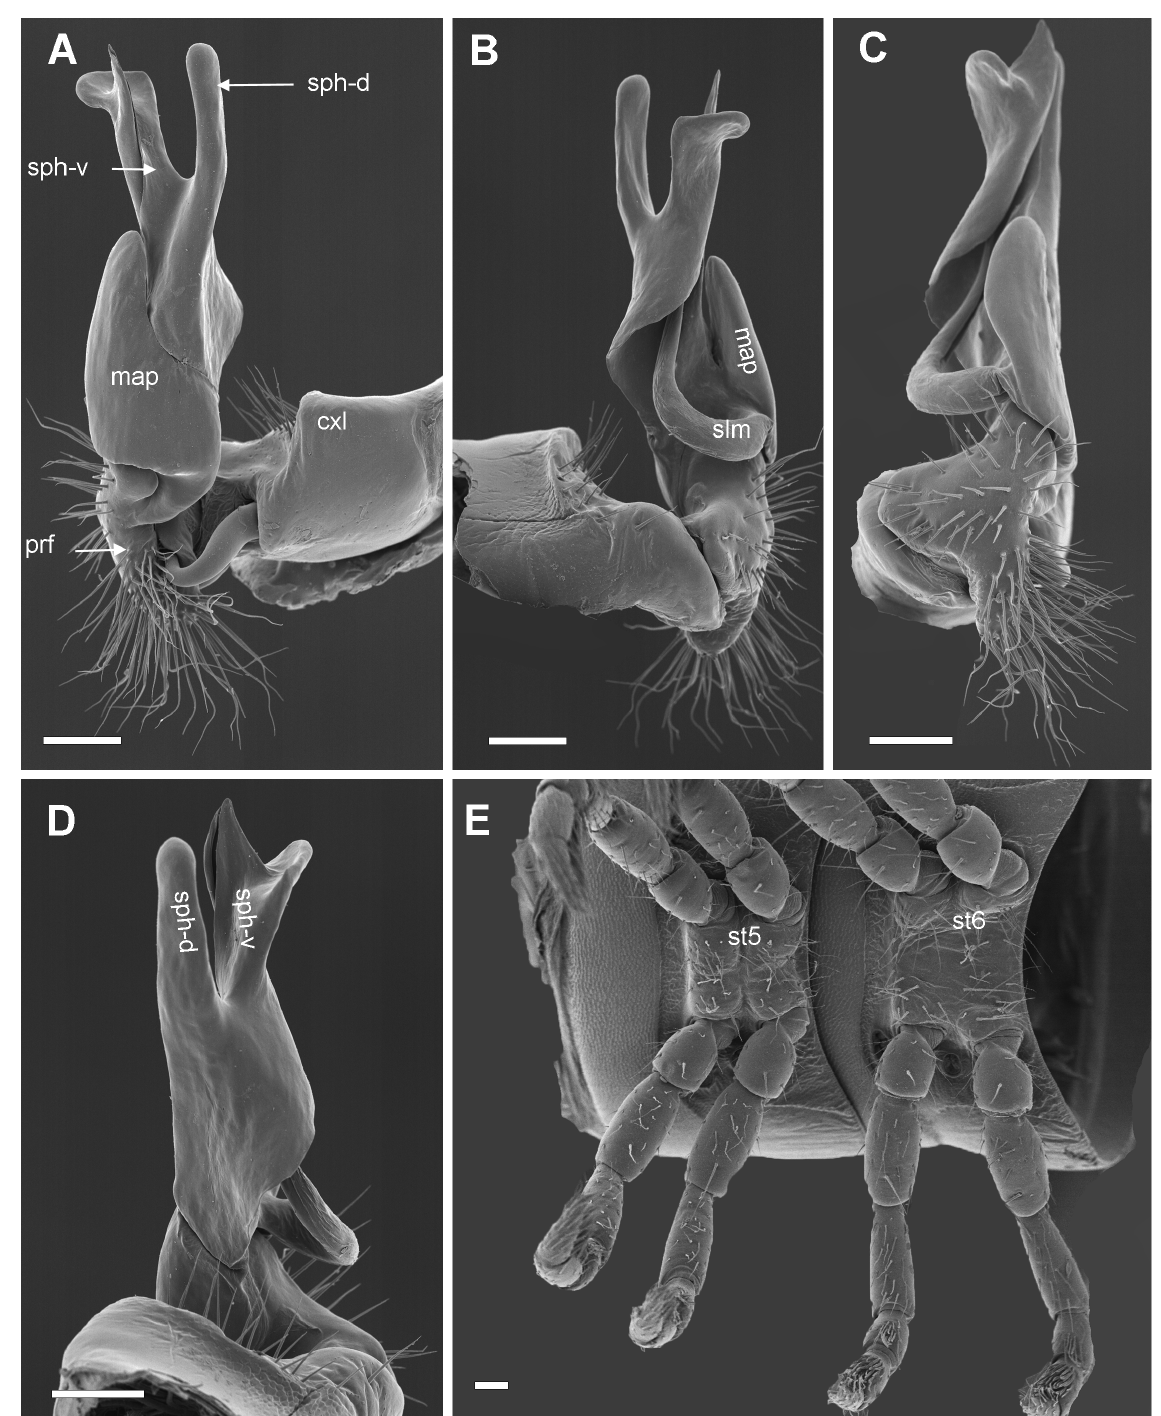
Fig. 36. Eviulisoma breviscutum sp. nov., paratype from forest below Mwanihana Peak. A–D . Right gonopod. A. Mesal view. B. Lateral view. C. Ventral view. D. Dorsal view. E . Body rings 5 and 6, showing unmodified sterna. Abbreviations cxl = coxal lobe; map = mesal acropodital process; prf = prefemoral part; slm = solenomere; sph-d , sph-v = dorsal and ventral lobes of solenophore; st5 , st6 = sterna 5 and 6. Scale bars: 0.1